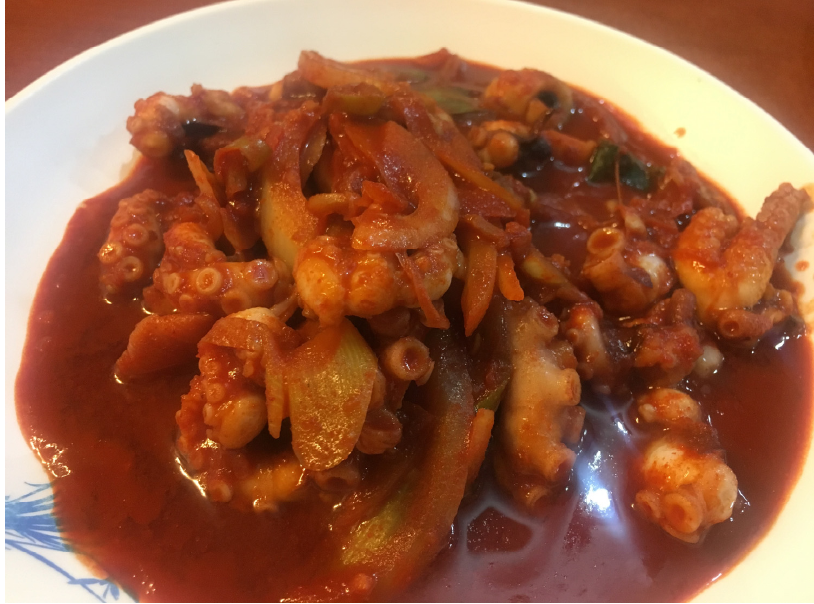
Figure A6. Ingredients: baby octopus, cabbage, carrot, chives, red chili, onion, oil, and condiments: red chili paste, red chili powder, soy sauce, sugar, garlic, ginger, salt, sesame.